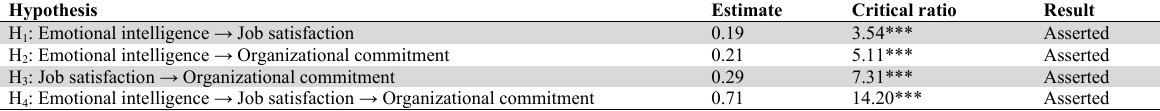
Regression Wight for Hypothesized Model Testing Result